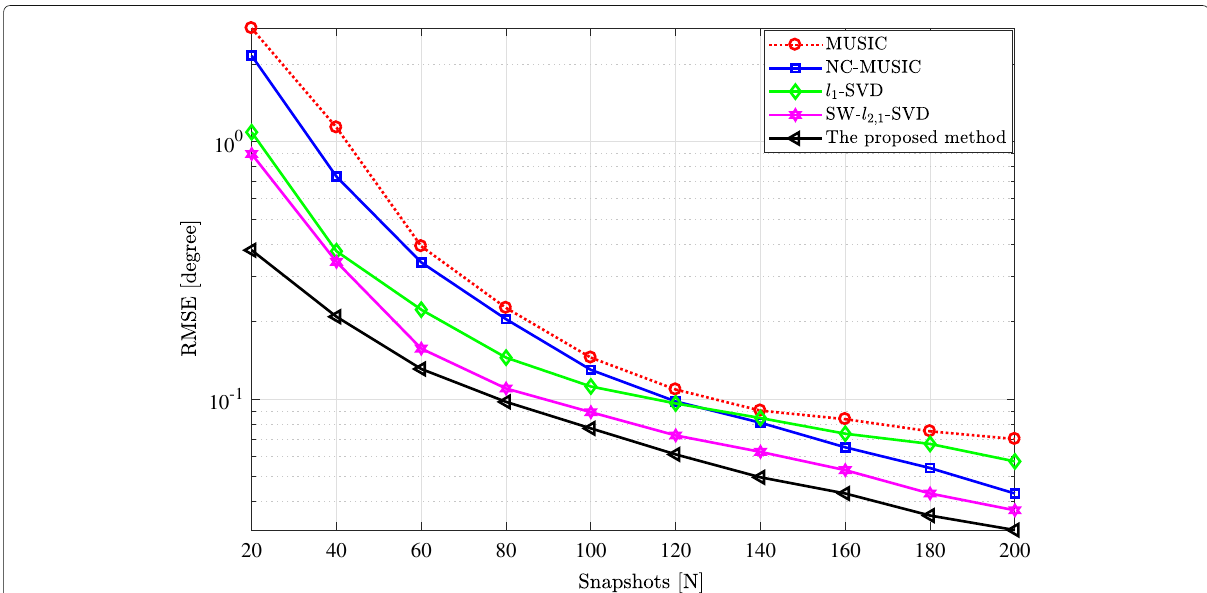
Fig. 4 RMSEs of MUSIC, NC-MUSIC, l 1 − SVD, SW − l 2,1 − SVD, and the proposed method as a function of the snapshots for SNR = 0 dB